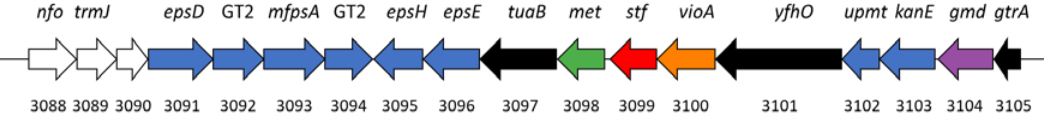
Figure 5. Putative sulfated glycosaminoglycan biosynthesis gene cluster in strain F21 T . Locus tag numbers without the “SCARR_” prefix are indicated below the genes. Genes encoding glycosyltransferases are marked blue, auxiliary proteins marked black, methyltransferases marked green, sulfotransferases marked red, transaminases marked orange, dehydratases marked purple and genes of other or unknown function are marked white. Genes with the prefix eps are homologs with putative EPS biosynthesis glycosyltransferases from Bacillus subtilis strain 168. Abbreviations from left to right: nfo , apurinic endonuclease; trmJ , tRNA methyltransferase; epsD , GT4; mfpsA , mannosylfructose-phosphate synthase (GT4); epsH , GT2; epsE , GT2; tuaB , teichuronic acid biosynthesis protein; met , methyltransferase; stf , sulfotransferase; vioA , dTDP-4-amino-4,6-dideoxy-D-glucose transaminase; yfhO , bacterial membrane protein; upmt , undecaprenyl-phosphate mannosyltransferase (GT2); kanE , α -D-kanosaminyltransferase (GT4); gmd , GDP-mannose 4,6-dehydratase; gtrA , GtrA-like protein.